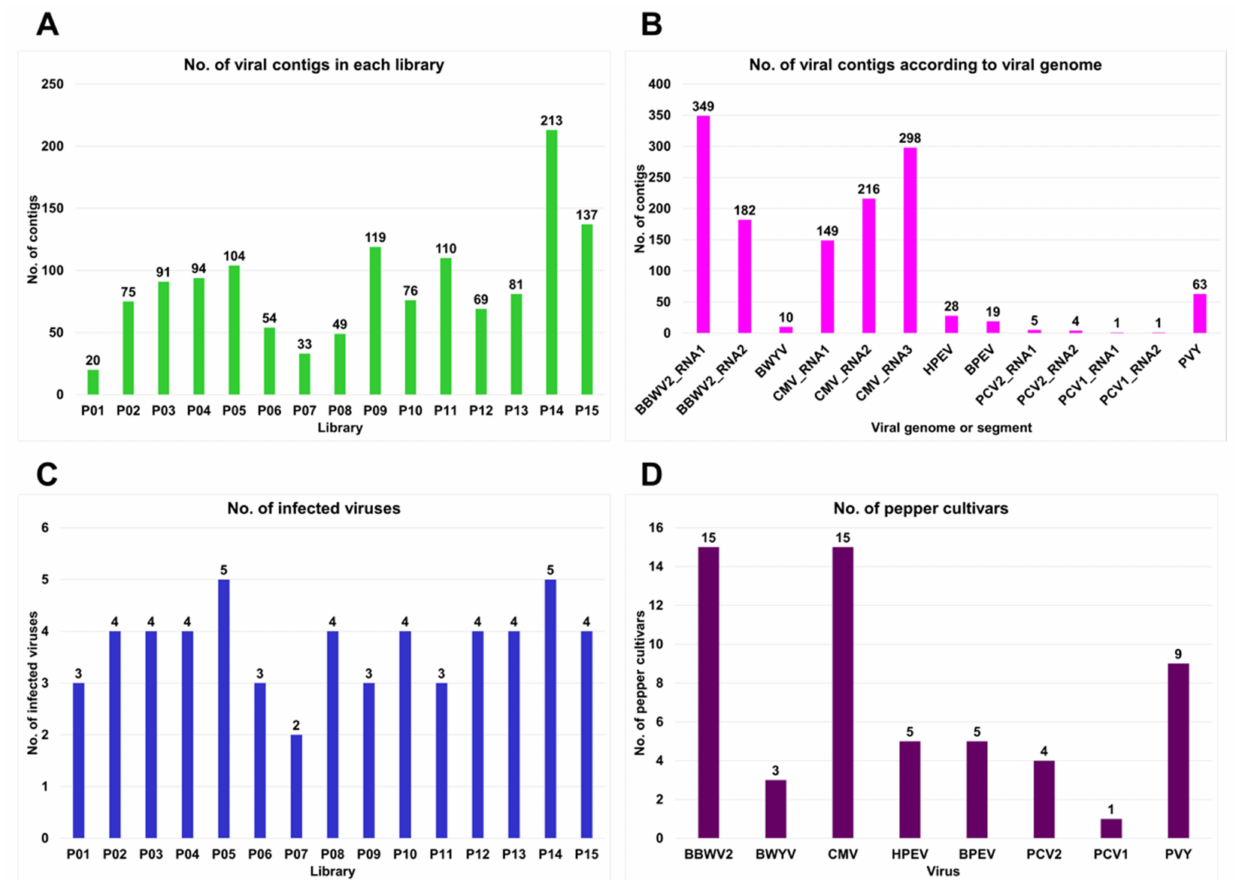
Figure 2. Number of identified virus-associated contigs and viruses from 15 different pepper cultivars: ( A ) number of viral contigs identified from each library; ( B ) number of viral contigs according to identified viral genome or segment; ( C ) number of viruses identified from each library; ( D ) number of pepper cultivars in which individual viruses were